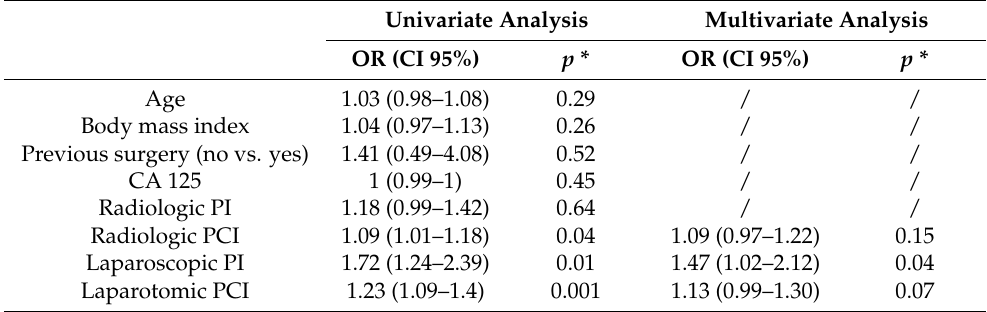
ratio; CI: confidence interval.